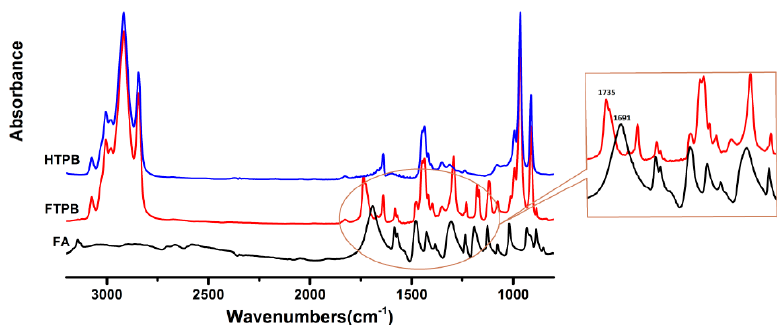
Figure 2. FT-IR spectrum of the comparison among hydroxyl-terminated polybutadiene (HTPB), FTPB, and furoic acid (FA): The peaks of furoic groups could be seen at 1730 cm − 1 (C=O bonds stretching), 1290, 1180, and 1120 cm − 1 (furan rings stretching), 1580, 1480, and 1350 cm − 1 (C=C bonds stretching), 1230 and 1080 cm − 1 (C–O–C bonds stretching), and 762 cm − 1 (furoic C–H bonds out-of-plane bending).